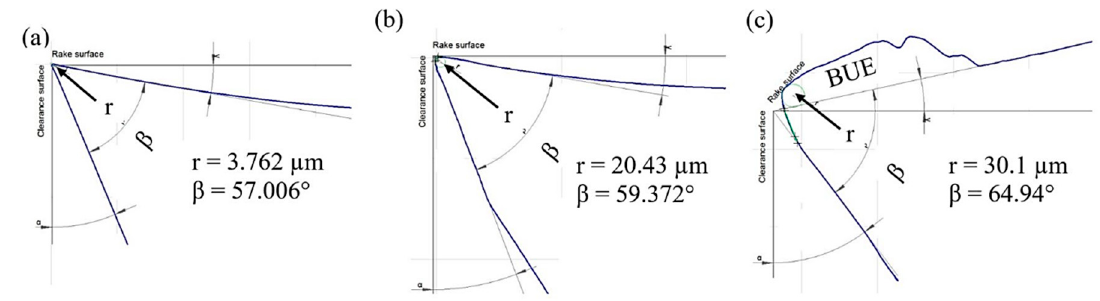
Figure 12. The e ff ect of machining technique on the cutting edge rounding at N = 56.52 m / min and f = Figure 12. The effect of machining technique on the cutting edge rounding at N = 56.52 m/min and f = 0.025 mm / rev for ( a ) new tool, ( b ) VAD A m = 0.25 mm, and ( c ) CD.